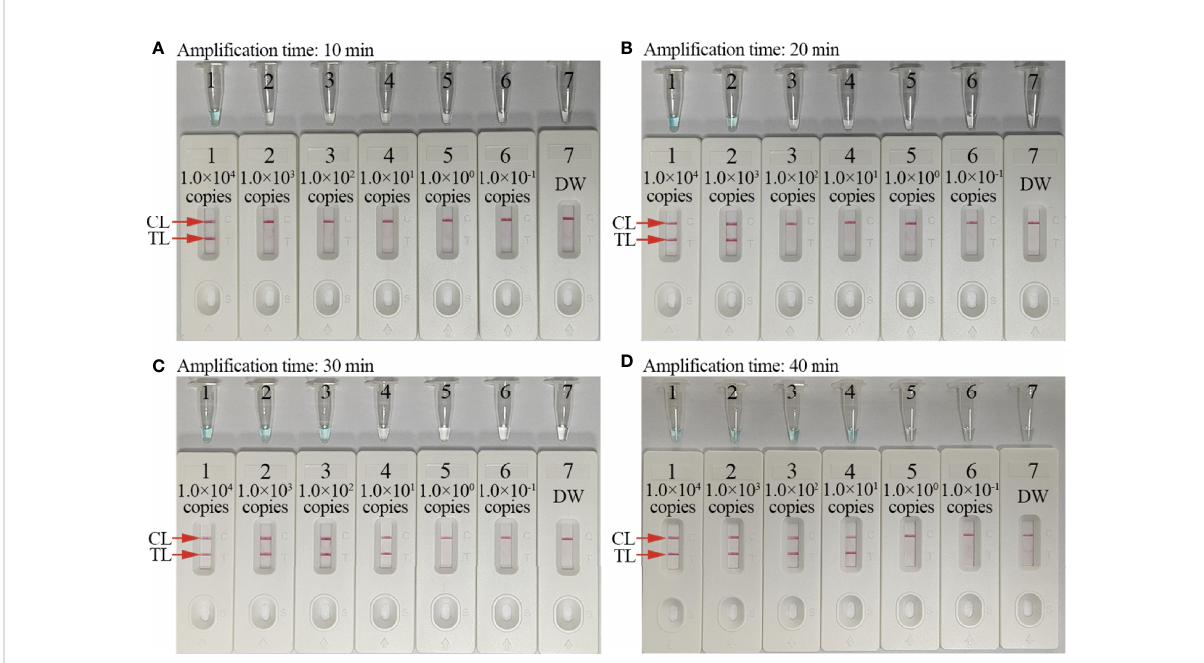
FIGURE 6 Optimal ampli fi cation time for the C. trachomatis -MCDA-AuNPs-LFB assay. Four reaction times ( A , 10 min; B , 20 min; C , 30 min; and D , 40 min) were evaluated at 67°C. Tubes/biosensors 1 – 7 represented C. trachomatis ompA template levels: 1.0 × 10 4 , 1.0 × 10 3 , 1.0 × 10 2 , 1.0 × 10 1 , 1.0 × 10 0 , 1.0 × 10 − 1 copies, and negative control (distilled water, DW), respectively. Results were simultaneously analyzed using malachite green (MG) and AuNP-LFB. The optimal limit of detection (LoD) occurred when the ampli fi cation lasted for 30 min (C) . CL: control line; TL: test